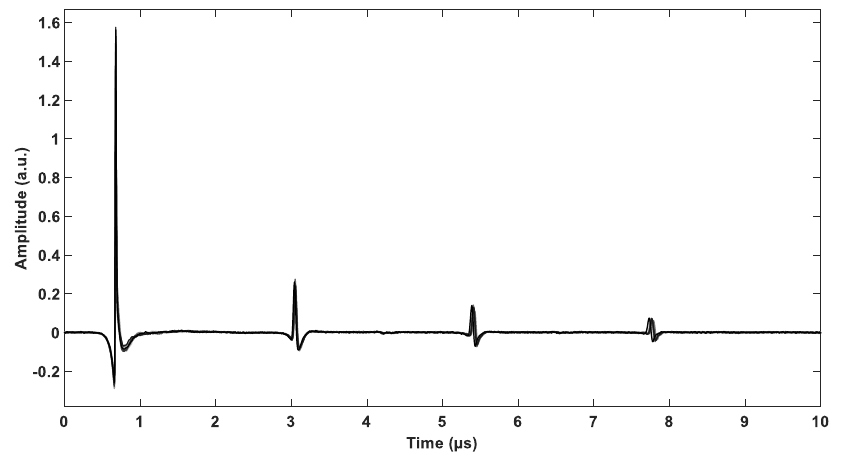
Figure 2. Ten typical bandpass − filtered A − scans from an online measurement in a hot strip mill [10]. The first peak at 0.7 µs is the generation event, and the following peaks are the consecutive backwall echoes.